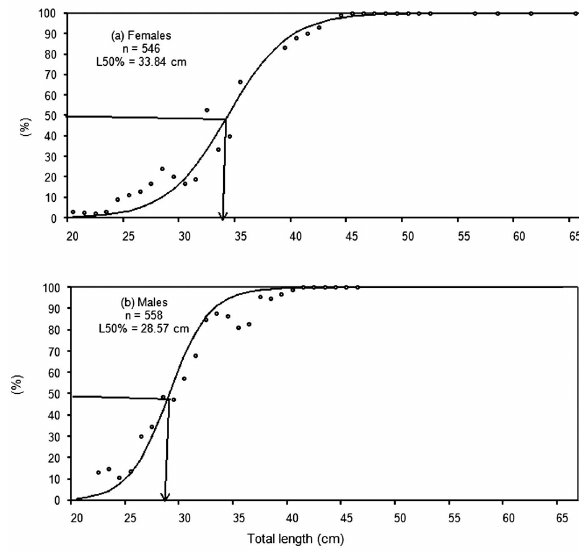
Fig . 5. – The bimonthly evolution of the mean gonadosomatic (GSI) and hepatosomatic (HSI) indexes for M. merluccius males during the sampling period.